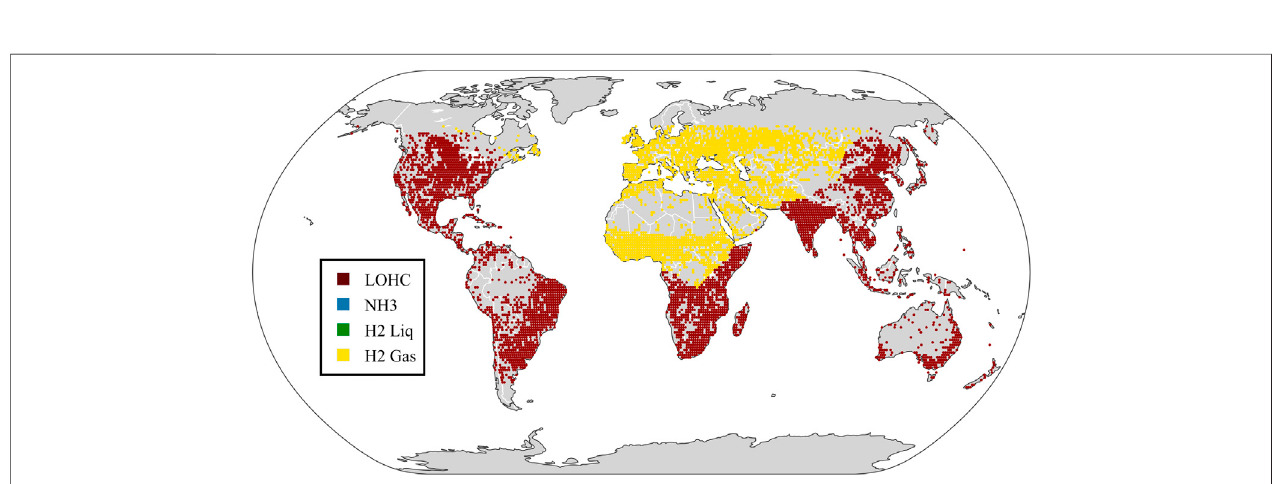
Frontiers in Energy Research |